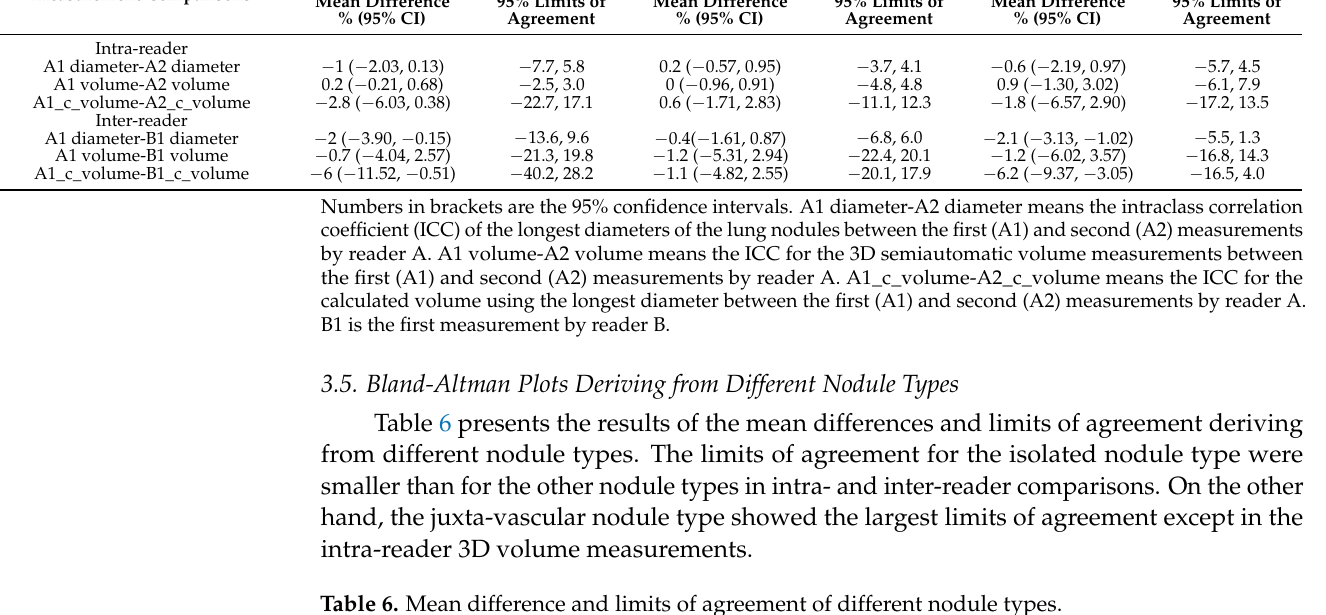
Table 6. Mean difference and limits of agreement of different nodule